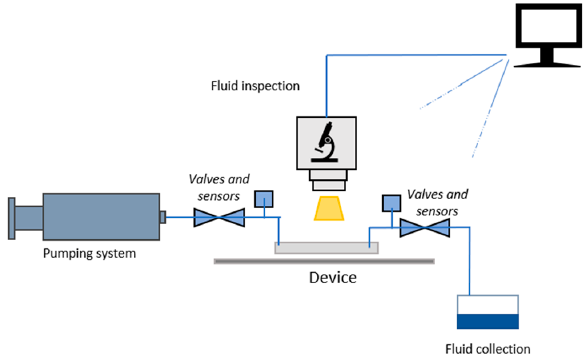
Figure 2. Sketch of a typical experimental set-up for microfluidic tests. Fluids are pumped into the device and collected at the outlet. The fluid dynamics occurring inside the device is monitored with appropriate imaging techniques and